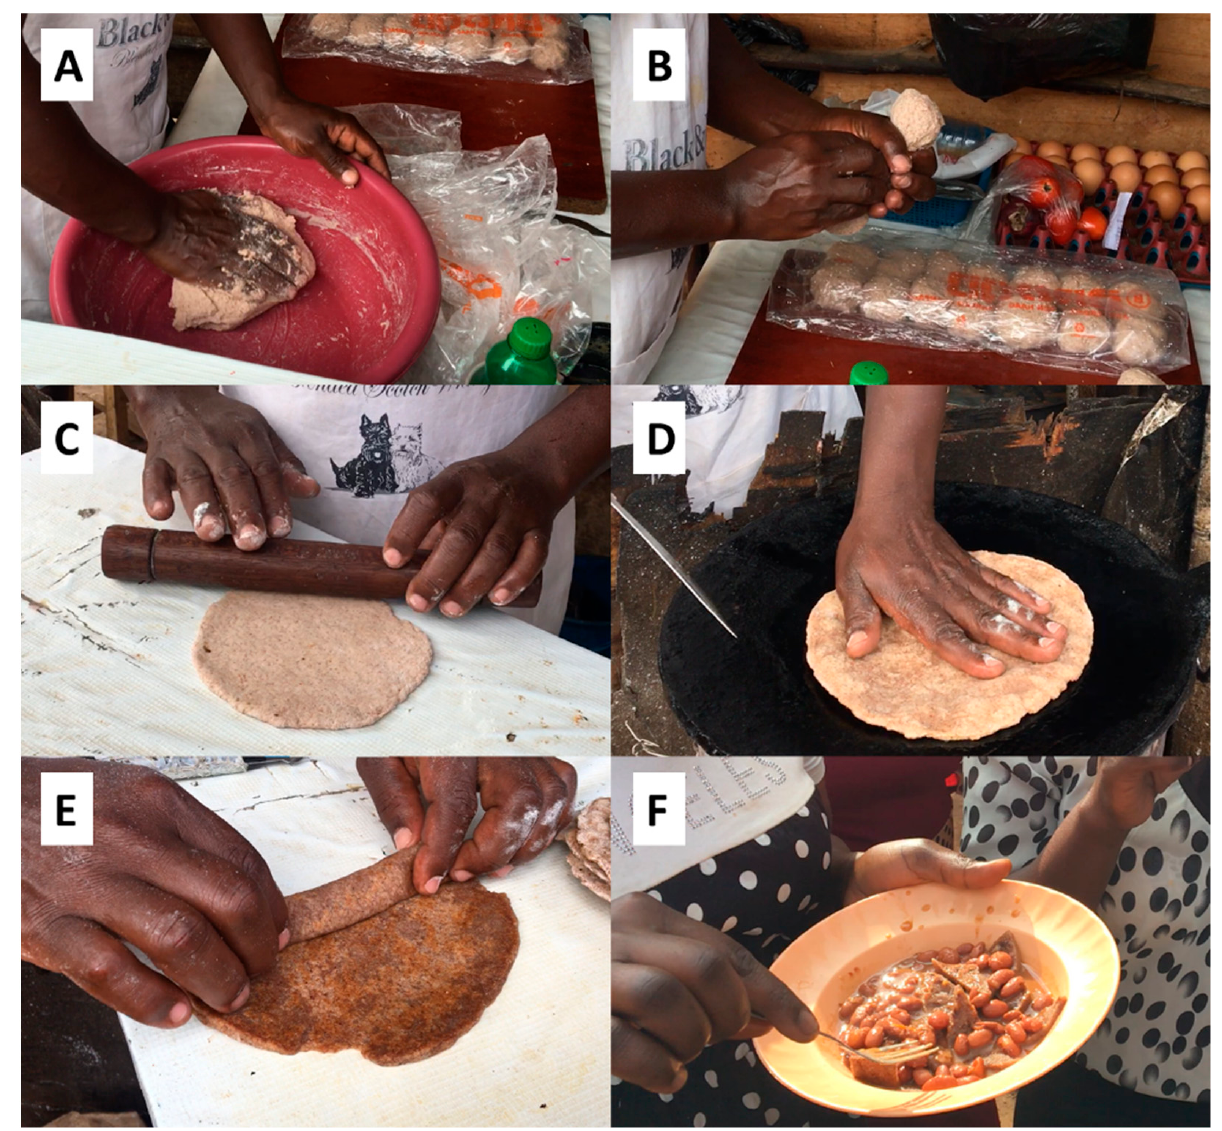
Figure 3. Main steps in the preparation of chapati by a street vendor using the CRCs-based dough GL9 (Table 1) without yeast. Dough mixing by hand in a plastic bowl ( A ), forming of dough balls